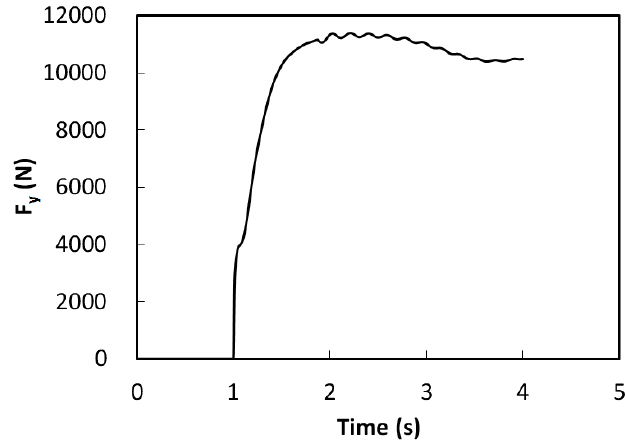
Figure 18. Total lateral force without control.